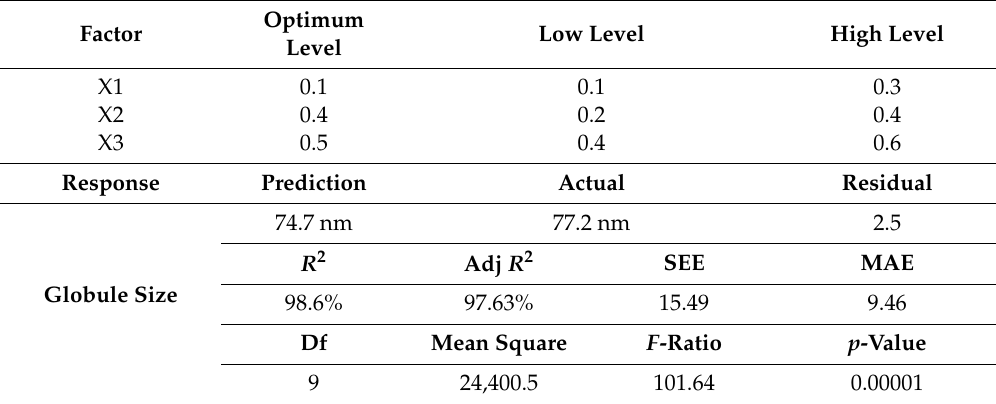
Table 2. Optimum levels for omega-3 SNEDDS factors (predicted, actual and residual values) and cubic model ANOVA for SNEDDS globule size. Optimum Factor Factor